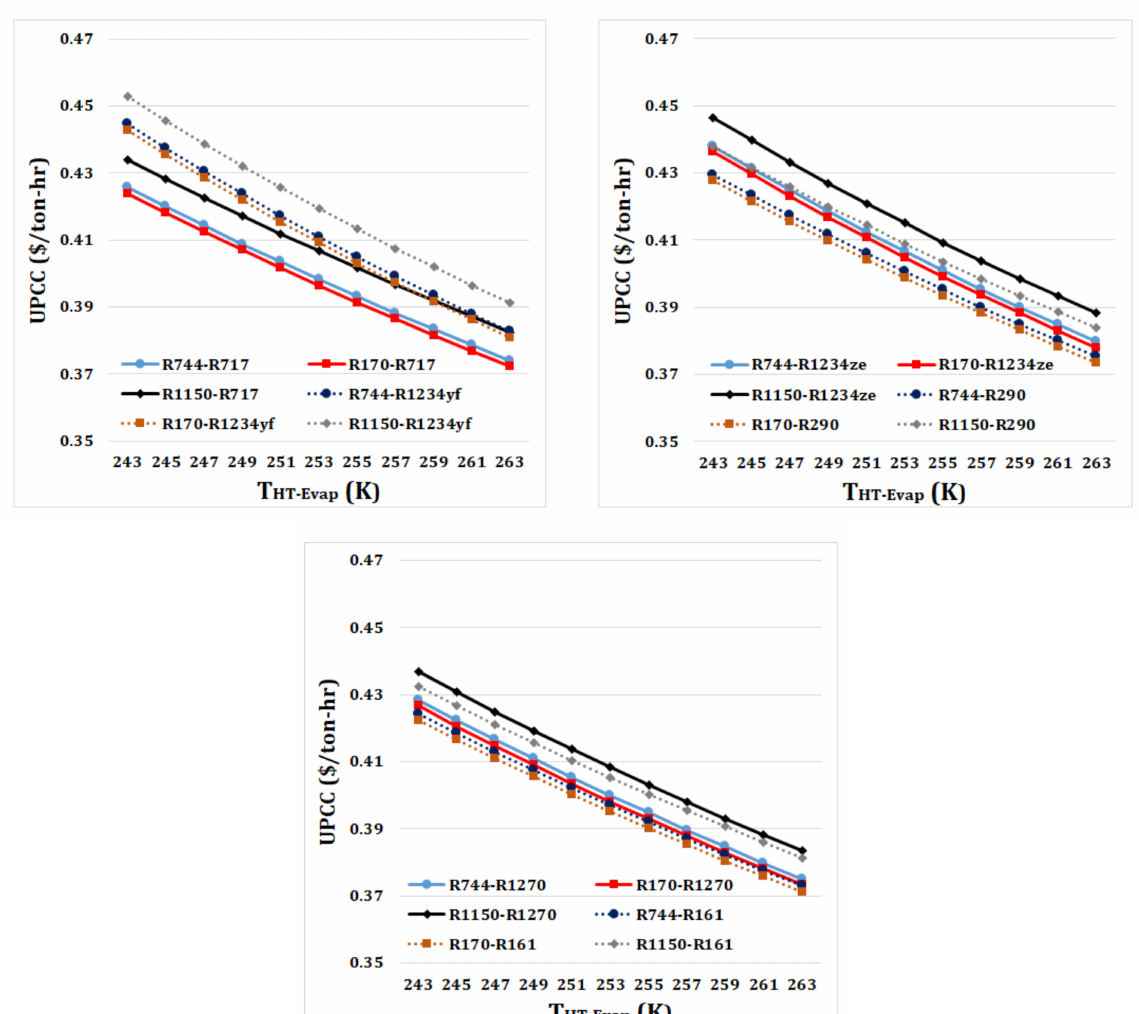
Figure 9. Effect of high-temperature evaporator ( T HT − Evap ) on the UPCC for different refrigerant